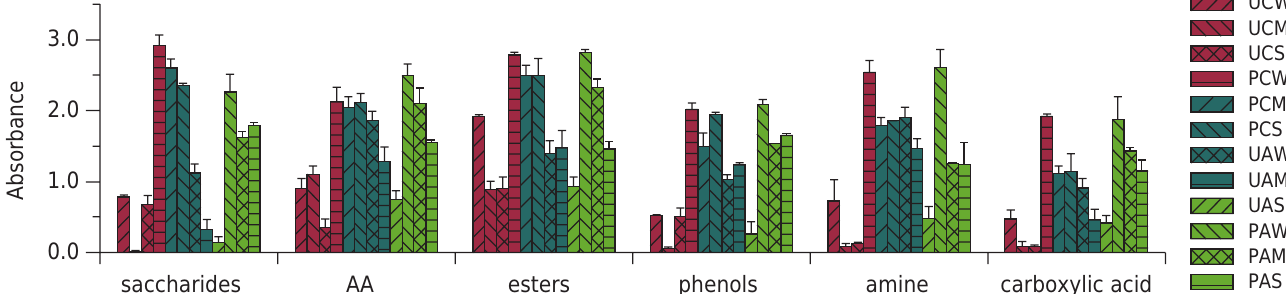
Figure 4. Carbon utilization profile of soil microbes on BIOLOG EcoPlate for different treatments. The bars above the columns indicate standard deviation. UCW: unplanted treatment with elevated CO 2 and well-watered condition; UCM: unplanted treatment with elevated CO 2 and mild drought condition; UCS: unplanted treatment with elevated CO 2 and severe drought condition; PCW: planted treatment with elevated CO 2 and well-watered condition; PCM: planted treatment with elevated CO 2 and mild drought condition; PCS: planted treatment with elevated CO 2 and severe drought condition; UAW: unplanted treatment with ambient CO 2 and well-watered condition; UAM: unplanted treatment with ambient CO 2 and mild drought condition; UAS: unplanted treatment with ambient CO 2 and severe drought condition; PAW: planted treatment with ambient CO 2 and well-watered condition; PAM: planted treatment with ambient CO 2 and mild drought condition; PAS: planted treatment with ambient CO 2 and severe drought condition.